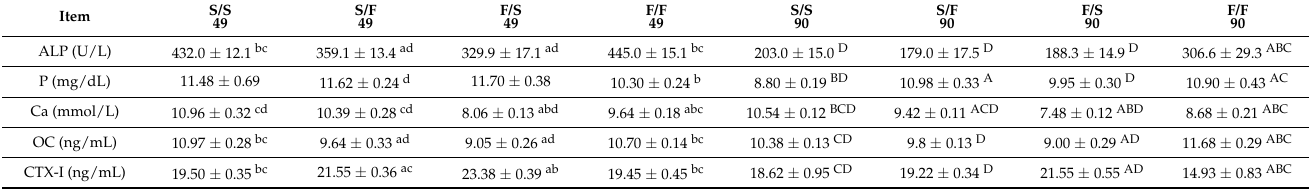
Table 5. The levels of the markers of bone metabolism, calcium, and phosphorus